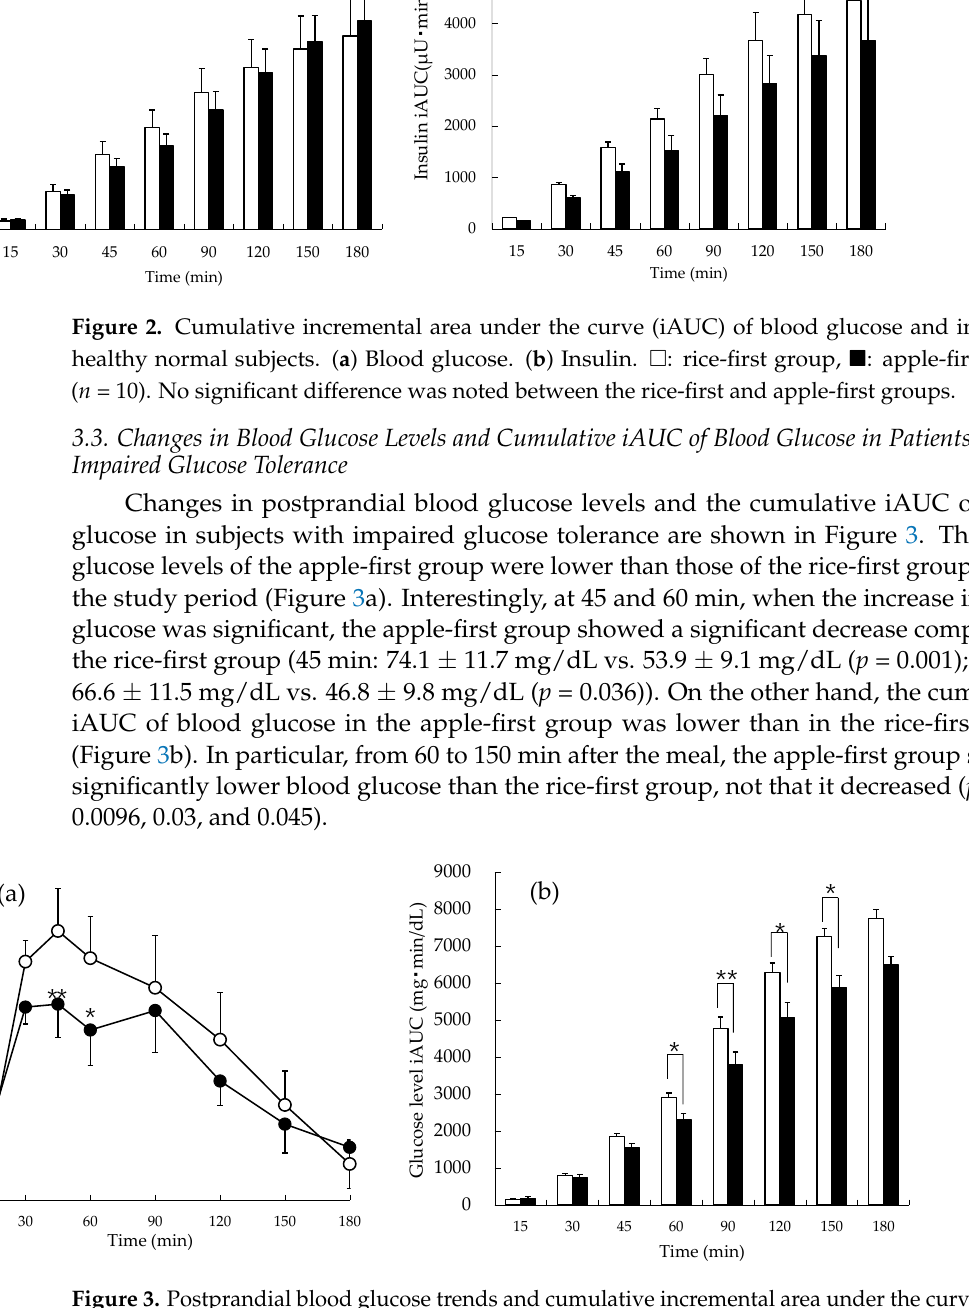
Figure 3. Postprandial blood glucose trends and cumulative incremental area under the curve (iAUC) in patients with impaired glucose tolerance. ( a ) Blood glucose level. ( b ) Cumulative iAUC value of blood glucose. ○ : rice- first group, ●: apple - first group, □: rice -first group, ■ : apple-first group. * p < 0.05; ** p < 0.01 ( n = 9).